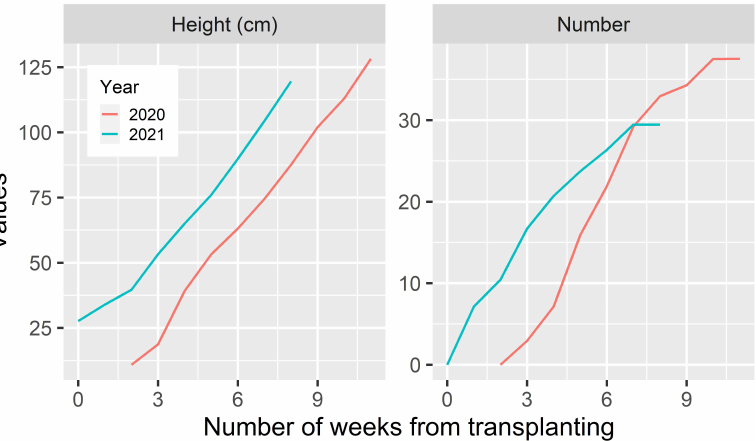
Figure 1. Plot of correlation among measured rice plant and yield characters in the experiments conducted in 2020 and 2021 at one site in Kenya and three sites in Tanzania to evaluate the effects of applying several biopesticides as dipping at transplanting and/or post-transplanting foliar spraying to control rice blast.